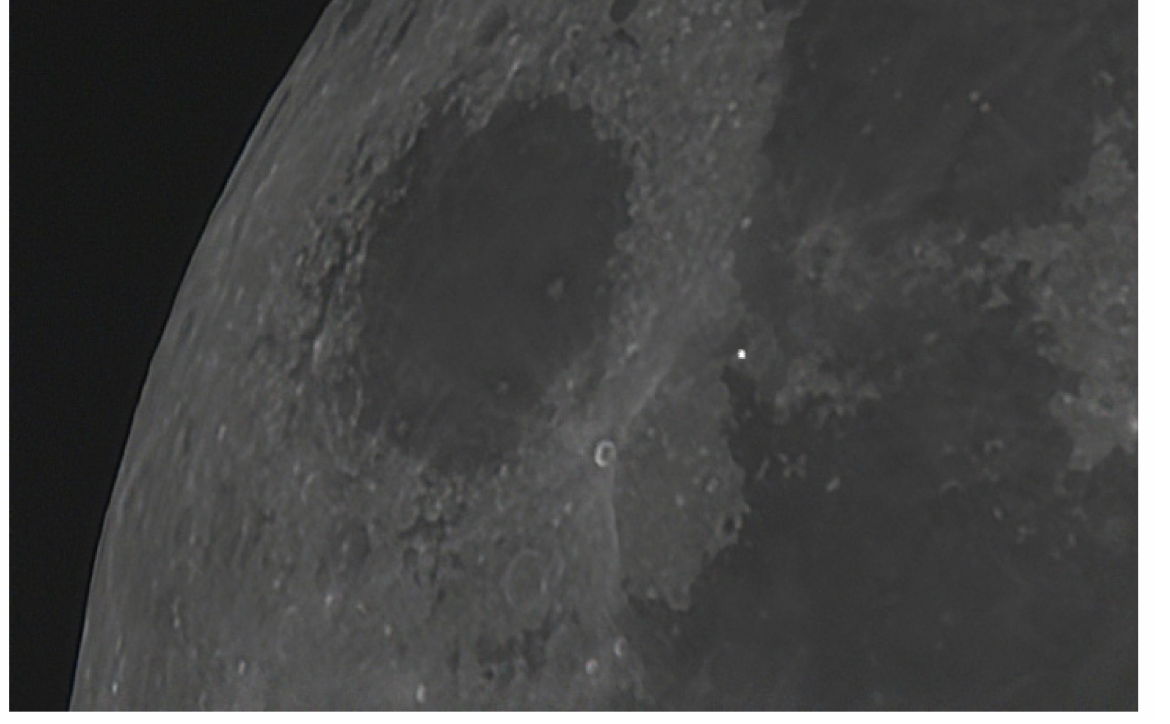
Figure 7. Flash 1 represented on the stacked